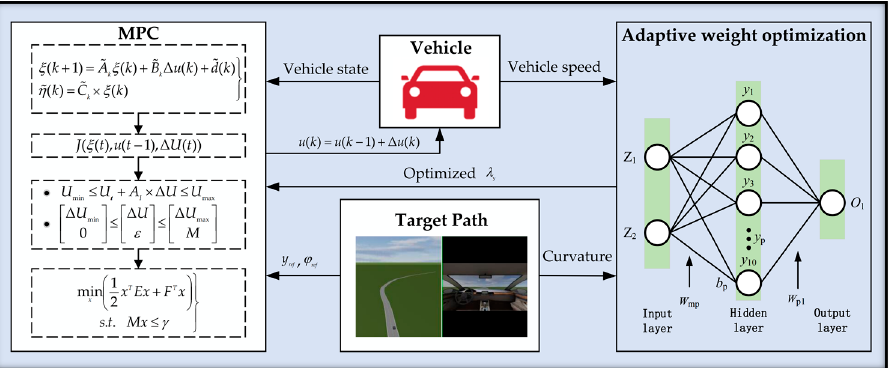
Figure 7. Overall architecture for path tracking.